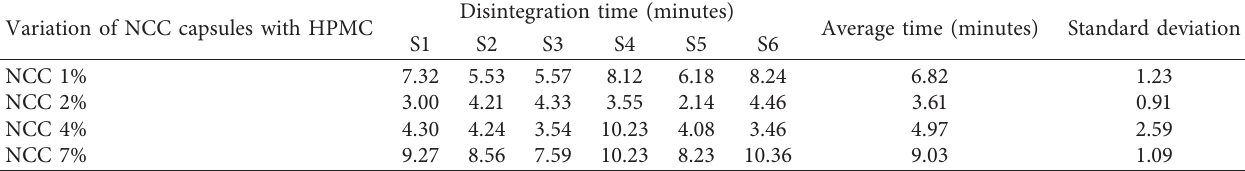
Table 5: Disintegration test results of the capsule shells from NCC produced from sugarcane bagasse waste added with hydroxypropyl methylcellulose (HPMC) and carbopol. Variation of NCC capsules with